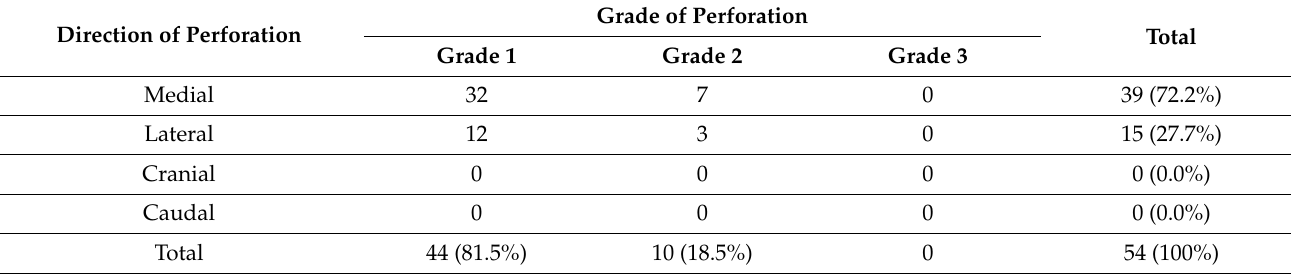
Table 3. Direction of screw perforation according to